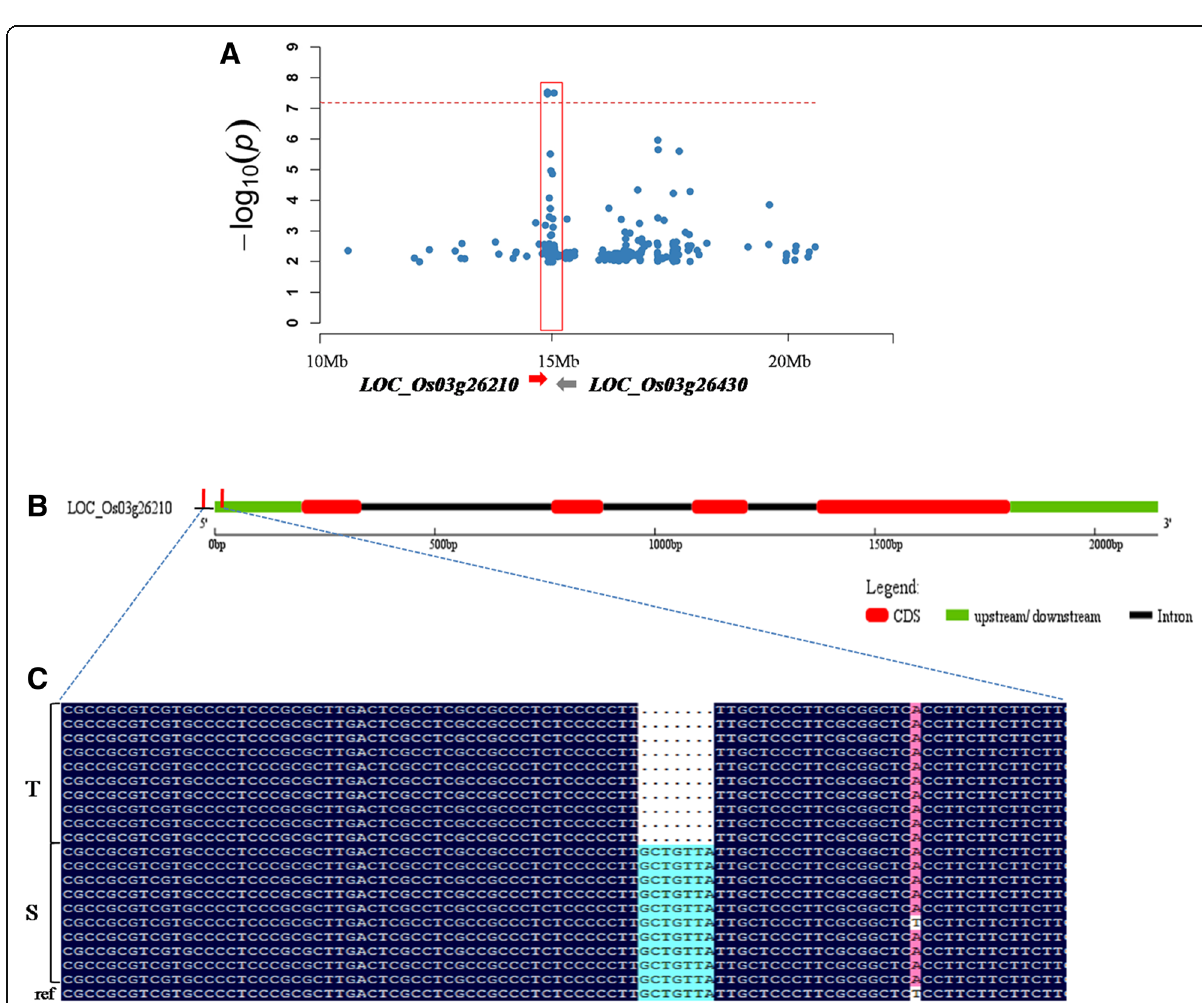
Fig. 4 The location of qSNC3 on chromosome 3 and sequence difference analysis of LOC_Os03g26210 . a , Colocalization of LOC_Os03g26210 and LOC_Os03g26430 with qSNC3 . The arrow indicates the location and direction of LOC_Os03g26210 and LOC_Os03g26430 . b , The gene structure of LOC_Os03g26210 . c , Sequence differences in LOC_Os03g26210 between ten alkalinity-tolerant varieties (low SAT) and ten alkalinity-sensitive varieties (high SAT). T indicates alkalinity-tolerant varieties, S indicates alkalinity-sensitive varieties, Ref is the reference sequence